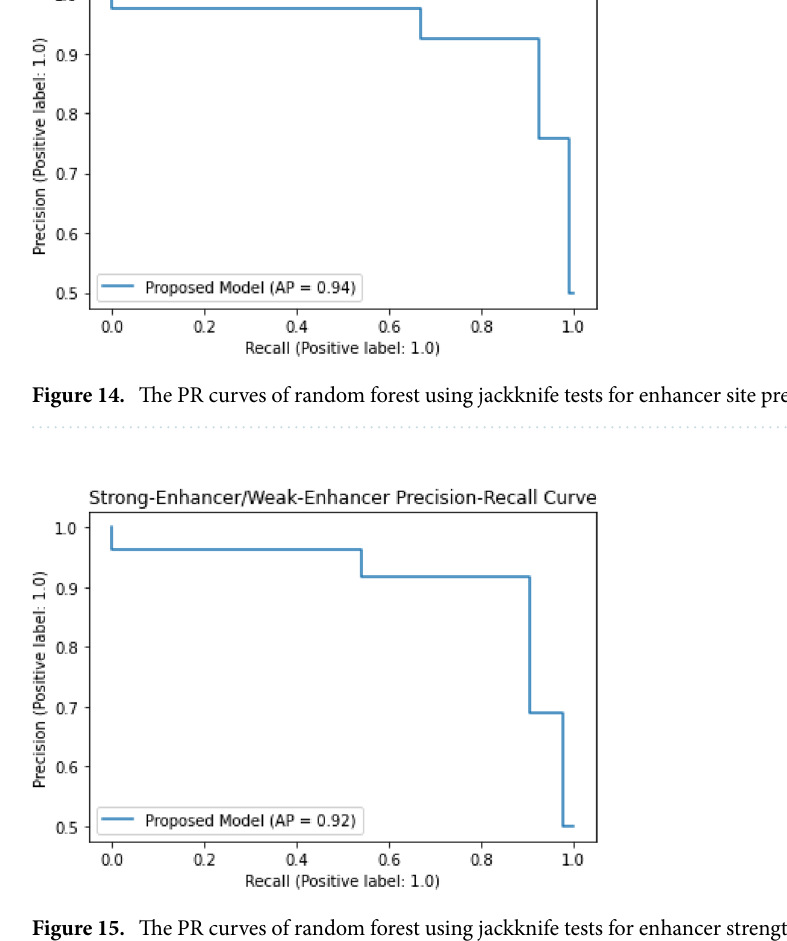
Figure 15. The PR curves of random forest using jackknife tests for enhancer strength